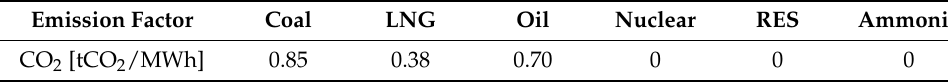
Table 4. Greenhouse gas emission factor.